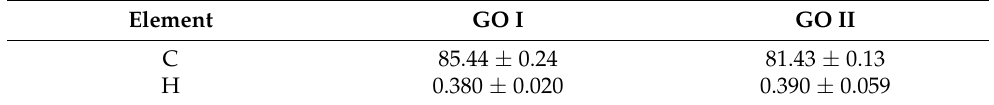
Table 2. Combustion analysis results (mass